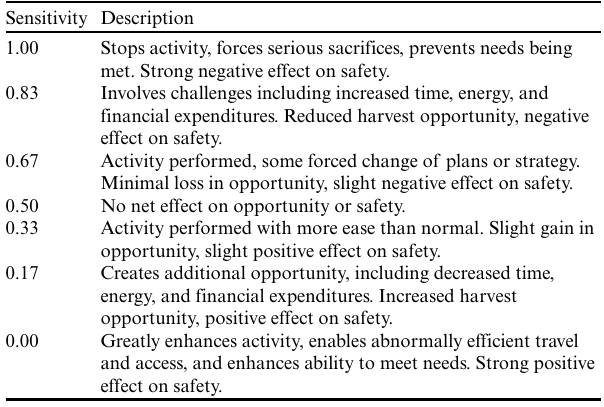
Table 1 . Components of vulnerability index equation used to